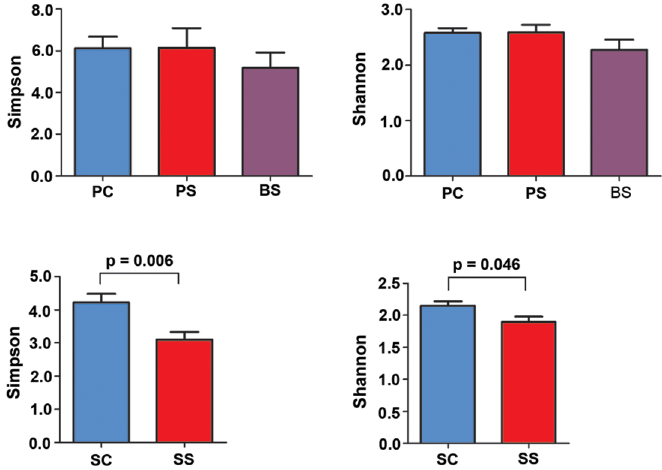
Fig 3. Microbiota diversity as calculated by Shannon and Simpson index. The Shannon and Simpson index values were significantly higher in salivary samples of the control group (SC) than the black stain group (SS). A tendency towards a reduction in the Shannon and Simpson index was observed in samples of black stain (BS) compared to dental plaque from the control (PC) and BS groups (PS); however, the difference was not significant. The error bars indicate mean with standard error.